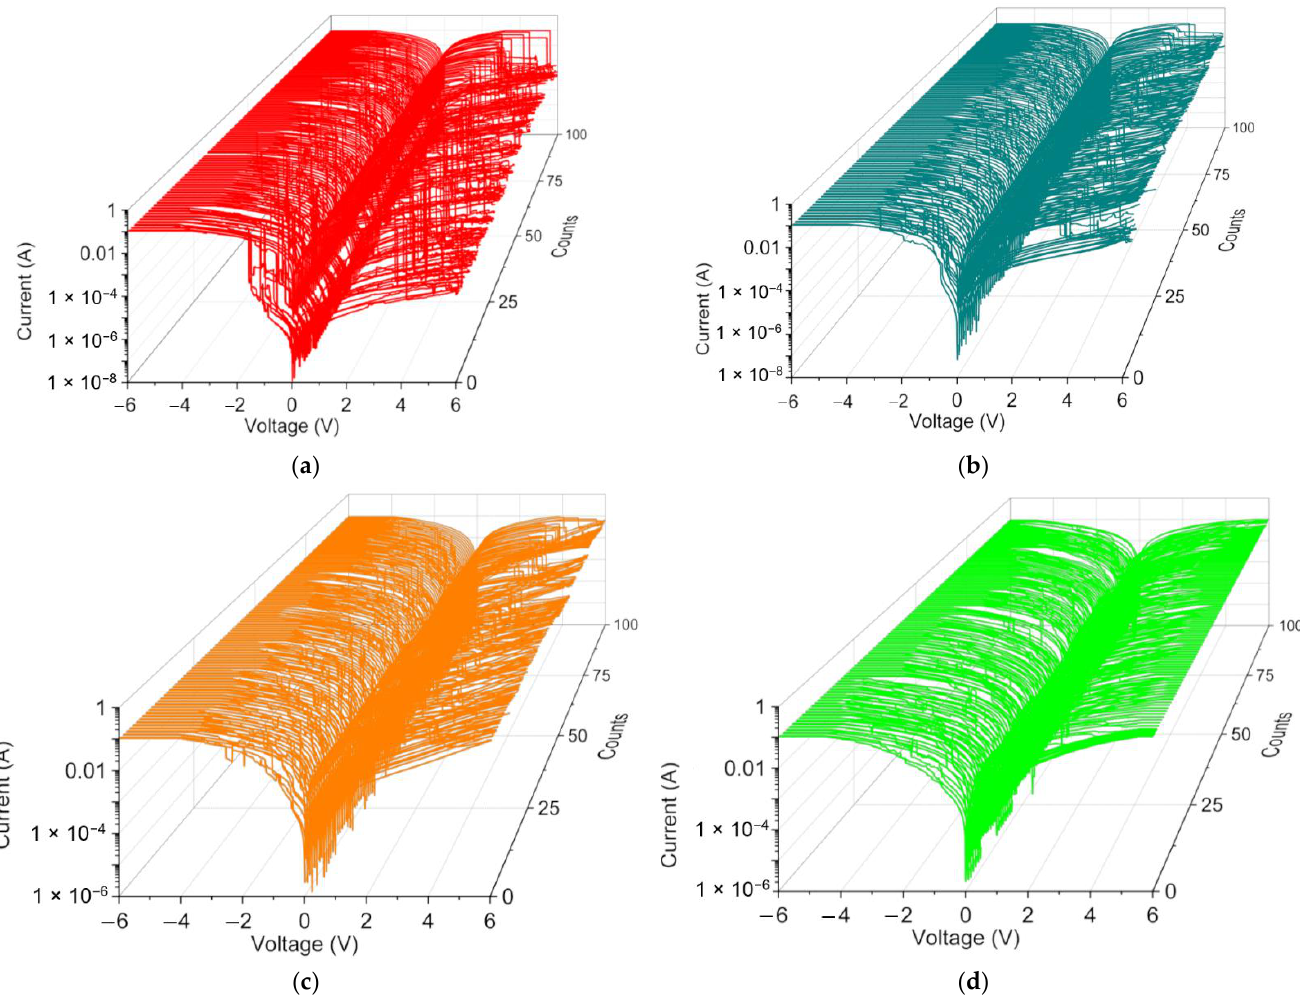
Figure 8. Ternary I – V characteristics of ( a ) ITO/B1/Ni, ( b ) ITO/B2/Ni, ( c ) ITO/B3/Ni, and ( d ) Figure 8. Ternary I–V characteristics of ( a ) ITO/B1/Ni, ( b ) ITO/B2/Ni, ( c ) ITO/B3/Ni, and ITO/B4/Ni for 100 consecutive cycles in DC double logarithmic modes. ( d ) ITO/B4/Ni for 100 consecutive cycles in DC double logarithmic